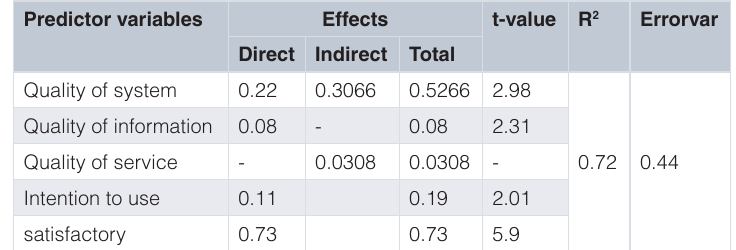
Table 4. The path coefficients for the variables used in the evaluation of the education